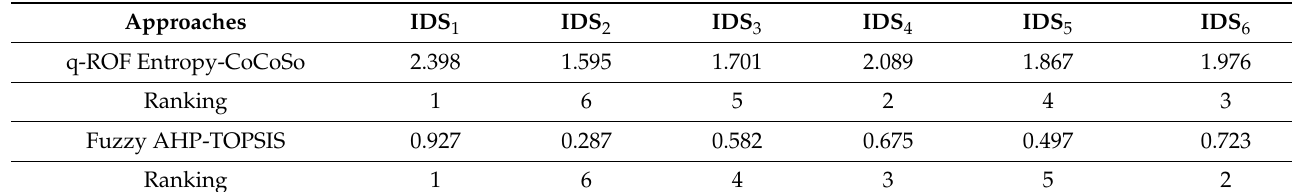
Table 17. Comparative analysis with other approach for ranking the IDSs.